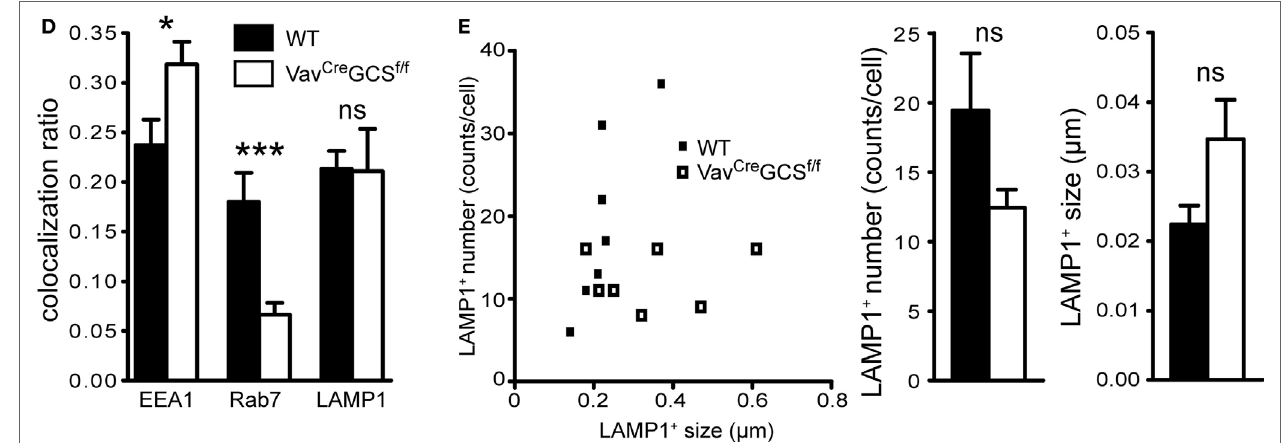
FigUre 5 | CD1d trafficking through early endosomes, late endosomes, and lysosomes. (a–c) In double-positive (DP) thymocytes, super-resolution microscopy was used to determine intracellular localization of CD1d molecules in early endosomes, late endosomes, and lysosomes visualized in the red channel by early endosome antigen 1 (EEA1), Rab7, and lysosome-associated membrane protein 1 (LAMP1), respectively. Co-localization areas were presented in white (right panels). DAPI was applied to visualize the nucleus (bar = 5 µm). (D) DP thymocytes were analyzed for co-localization between green and red signals using the ImageJ’s co-localization plugin, and the ratio of co-localized and total green area was plotted and statistically analyzed using the unpaired t-test. Although a significant shift from late to toward early endosomes could be observed in Vav Cre GCS f/f DP thymocytes, the amount of CD1d in lysosomes was equal. Shown are means ± SEM, N = 20 cells per group. (e) A tendency toward less but larger LAMP1 + lysosomes could be seen in DP thymocytes of Vav Cre GCS f/f mice, however, the difference was not statistically significant. The bars show means ± SEM, N = 7 cells per